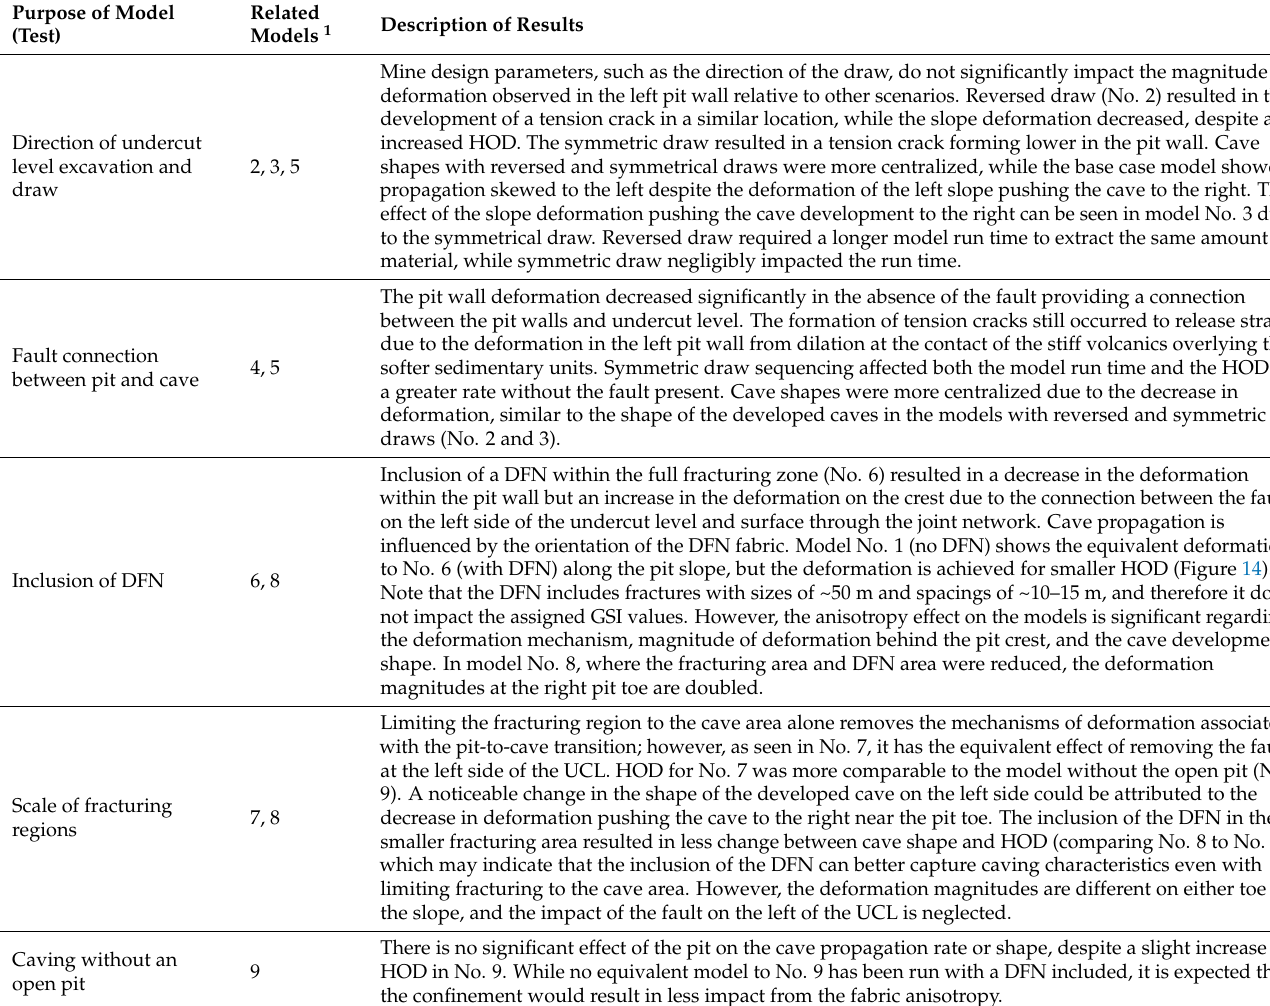
Figure 16. FDEM model results for models No. 1 and No. 6 after 1450 m 2 ± 1% material removed. Maximum XY displacement contours. Developed cave shape comparison defined by 1 m vertical displacement. Table 5. Comments concerning the results of the conceptual pit-to-cave